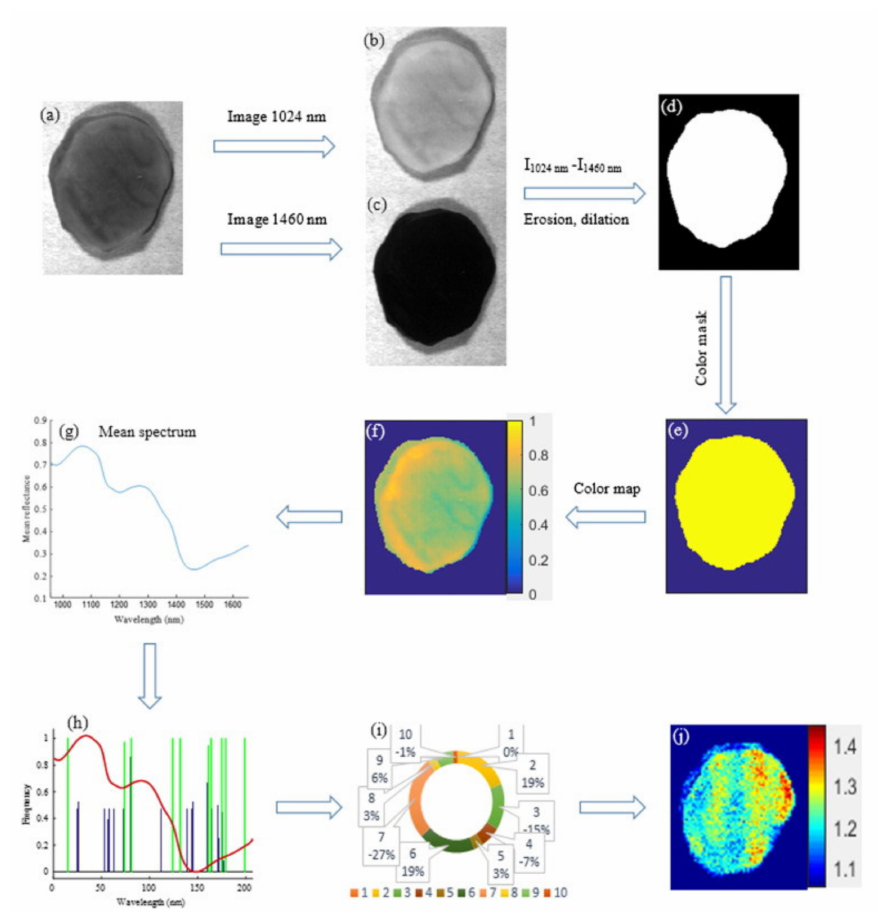
Figure 2. Visualization process of potato SG based on hyperspectral imaging. ( a ) The corrected hyperspectral image, ( b ) band image at 1024 nm, ( c ) band image at 1460 nm, ( d ) mask image, ( e ) color mask, ( f ) spectral reflectance index, ( g ) average spectrum, ( h ) feature variable selection, ( i ) feature variable reduction, and ( j ) distribution map of SG